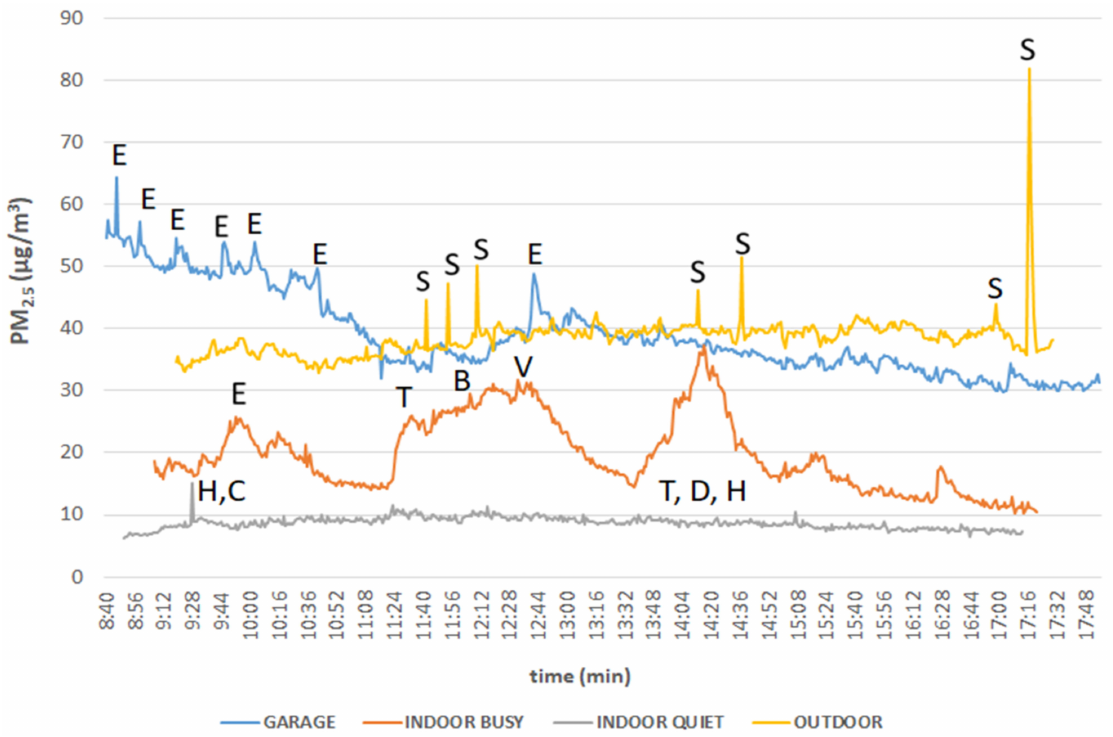
Figure 2. Daily patterns of PM 2.5 concentrations measured by KORA in different environments: (a) indoor busy, (b) indoor quiet, (c) outdoors, (d) garage, respectively. The labels (E: car exhausts, S: cigarette smoke, H: hammering works, C: crane movements, T: crane truck circulation, B: building and construction works, V: local forced ventilation, D: drilling work) describe the local ongoing activities (a complete list is given in Table